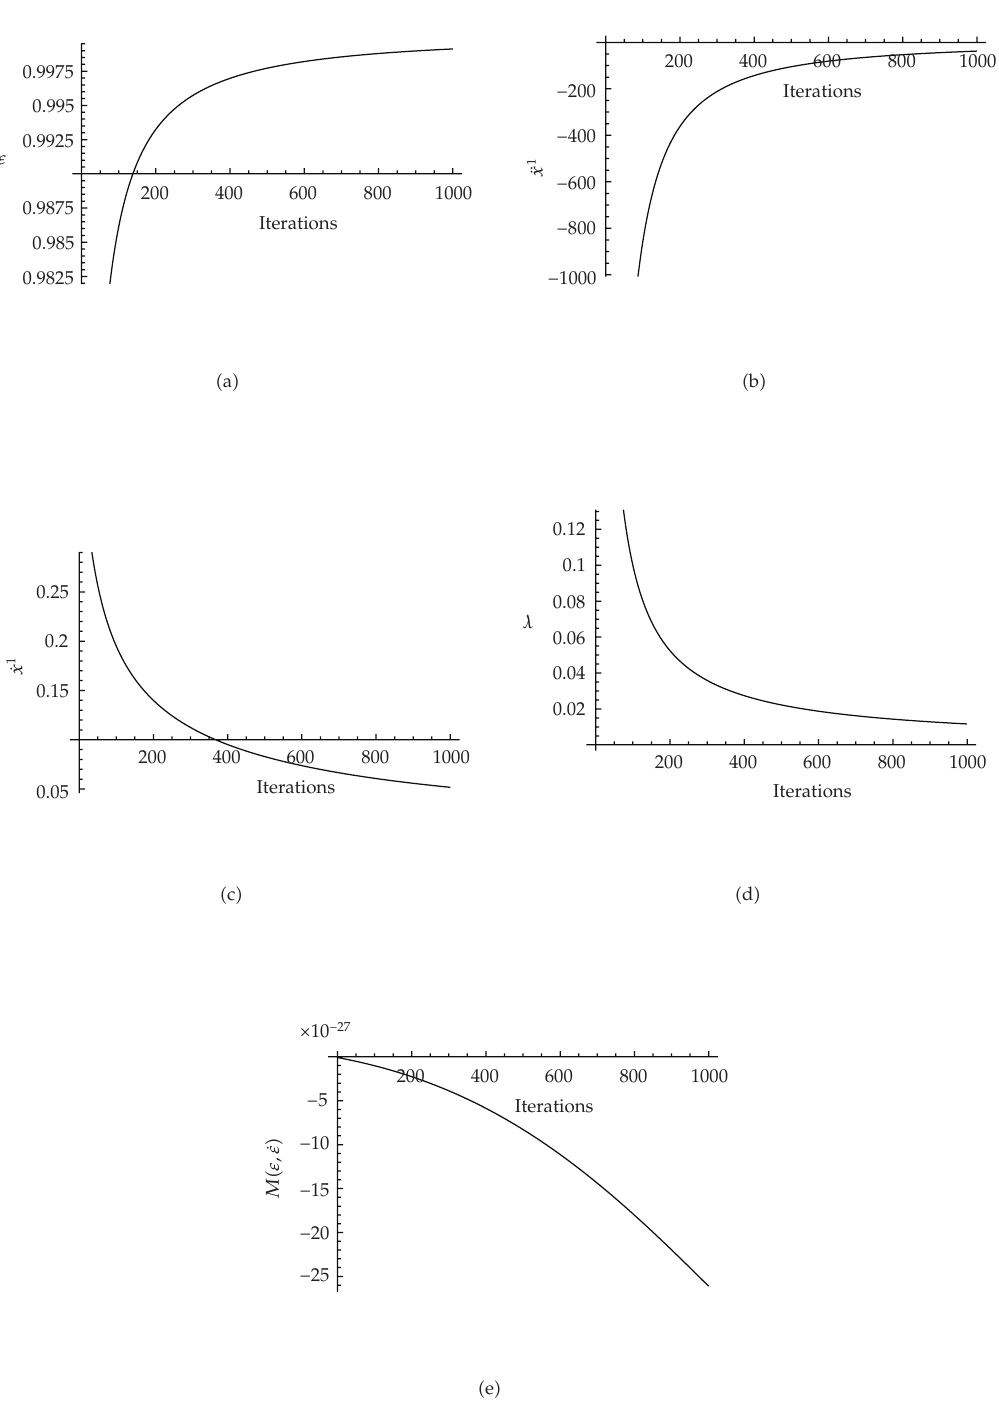
Figure 11: (cid:6) a (cid:7) and (cid:6) b (cid:7) ε and the acceleration component ¨ x 1 as functions of the number of time iterations. (cid:6) c (cid:7) and (cid:6) d (cid:7) The velocity component ˙ x 1 and the Lyapunov exponent as functions of the number of time iterations. (cid:6) e (cid:7) The e ff ective (cid:6) universal time (cid:7)